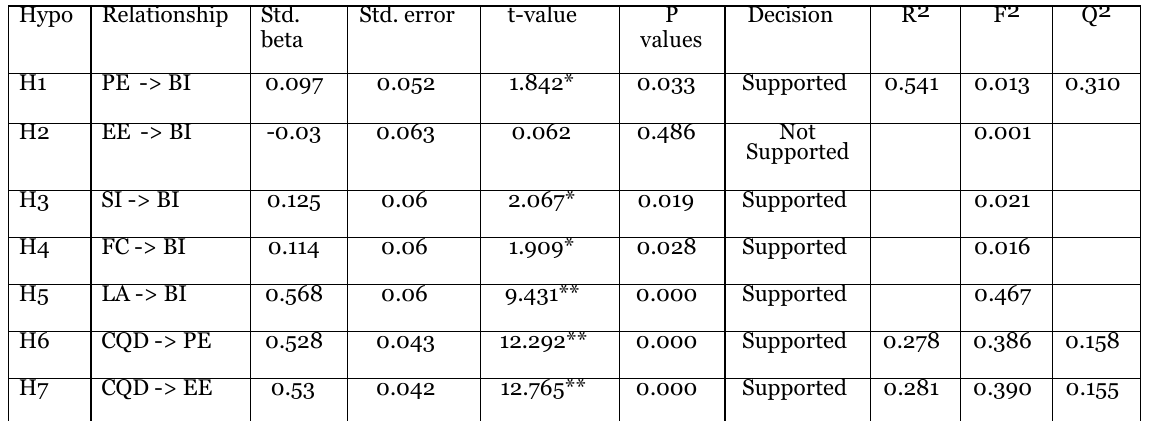
Discriminant Validity of Measurement